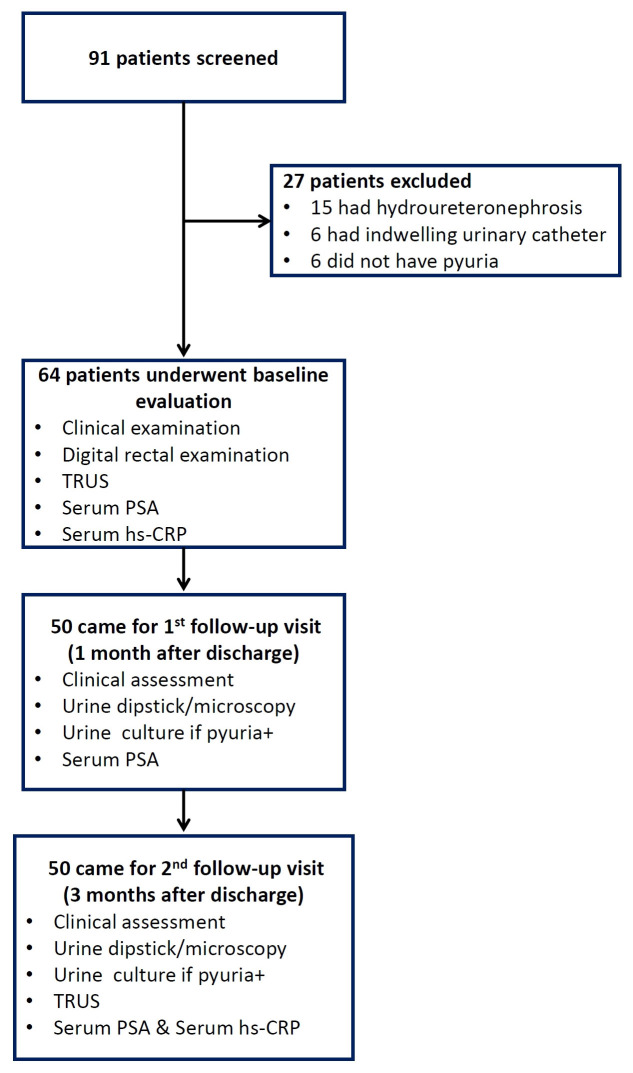
Flow of participants through the study.TRUS, transrectal ultrasound; PSA, prostate-specific antigen; hs-CRP, high sensitivity C-reactive protein.